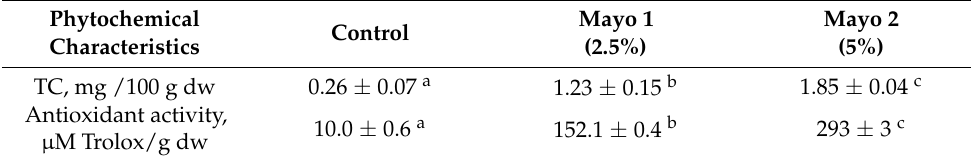
Table 6. Phytochemical characteristics of value-added mayonnaise. Phytochemical Characteristics